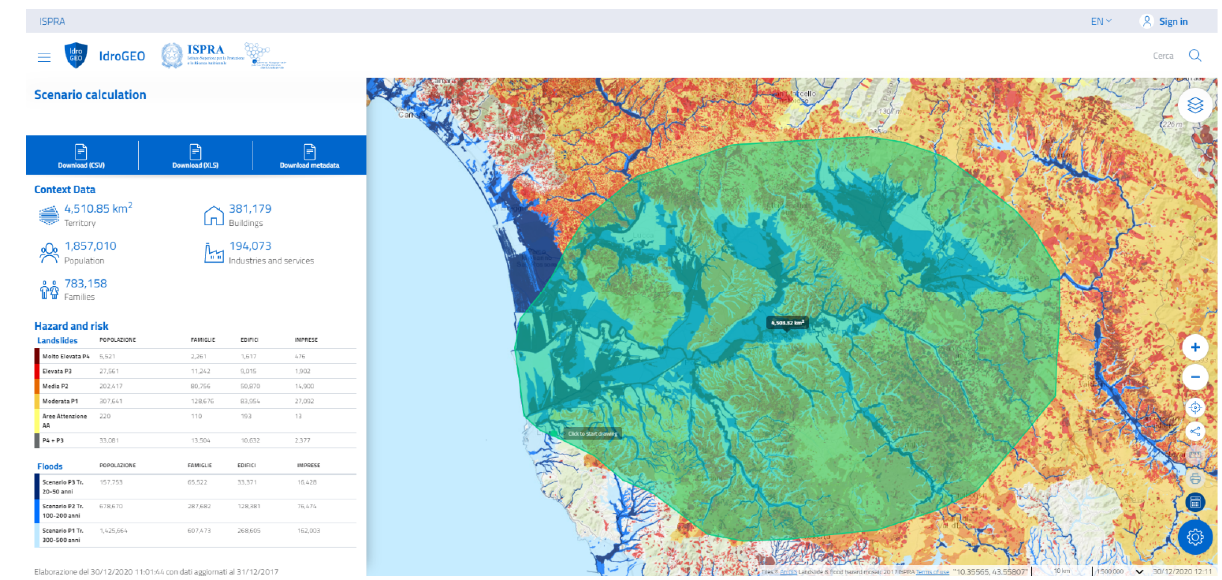
Figure 6. Scenario calculation tool.